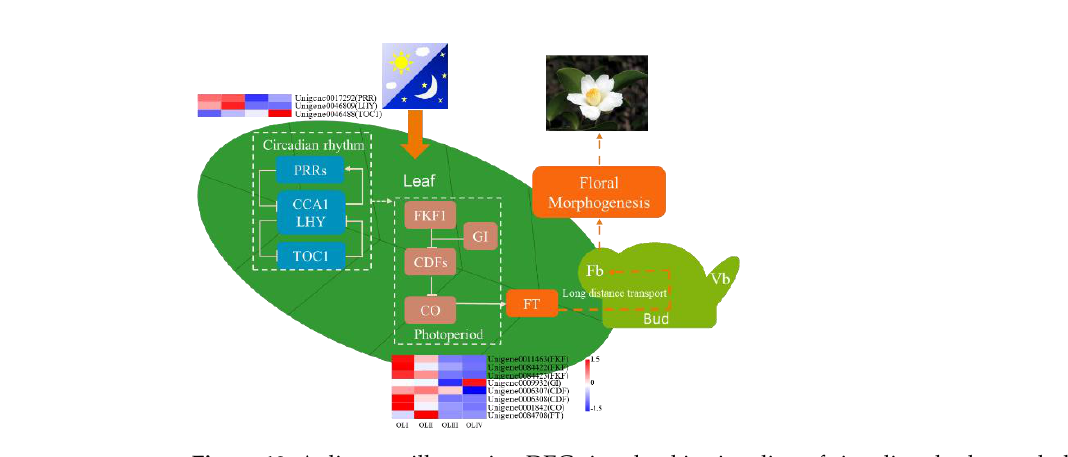
Figure 10. A diagram illustrating DEGs involved in signaling of circadian rhythm and photoperiod in old leaves to initiate flowering. Fb: Flower bud; Vb: Vegetative bud.